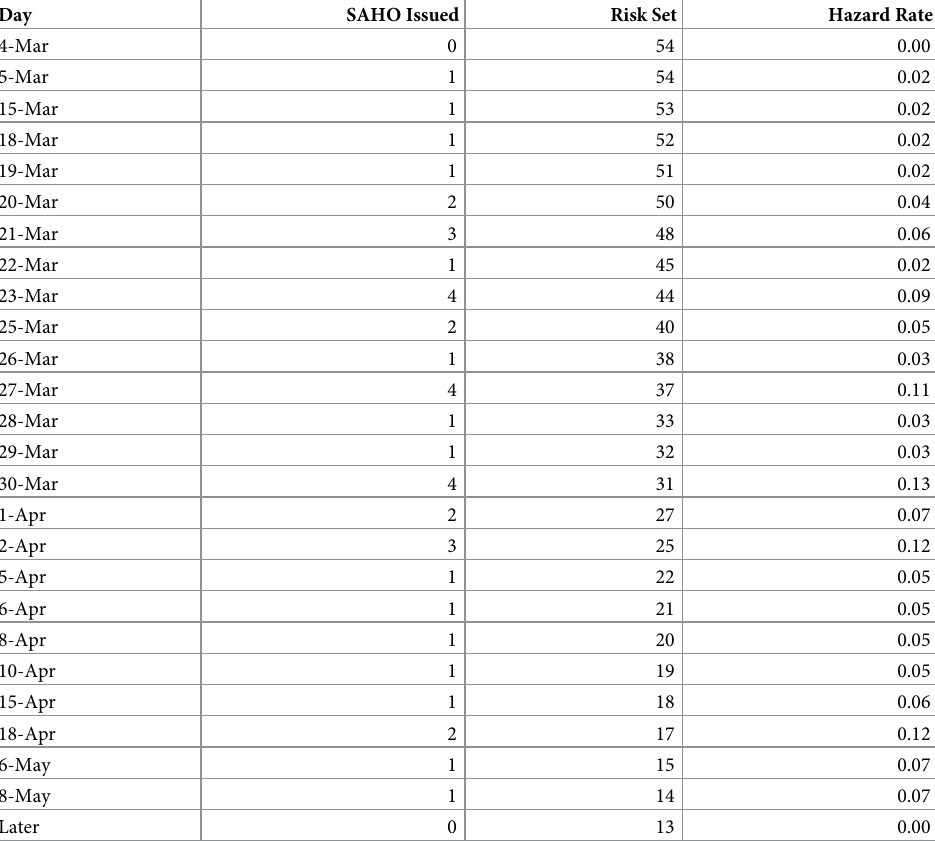
Table 1. Life table for pooled